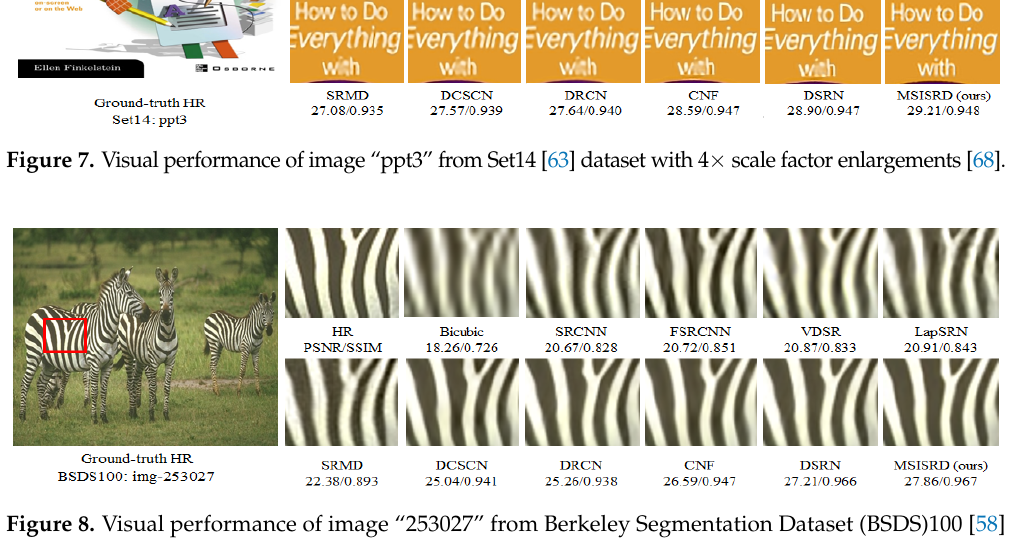
Figure 8. Visual performance of image “253027” from Berkeley Segmentation Dataset (BSDS)100 [58] dataset with 4 × scale factor enlargements